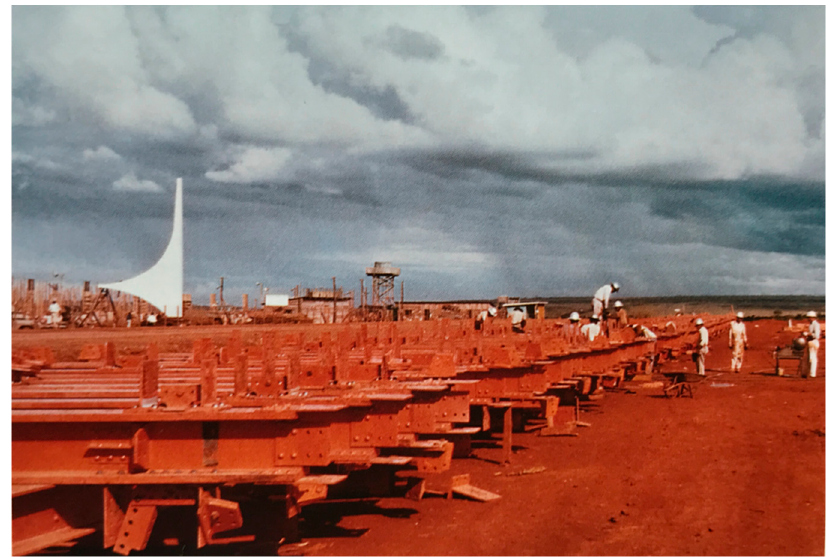
Figure 13. Photograph from the construction of Brasília, NOVACAP archive at Arquivo Público do Distrito Federal, c. 1957–8.